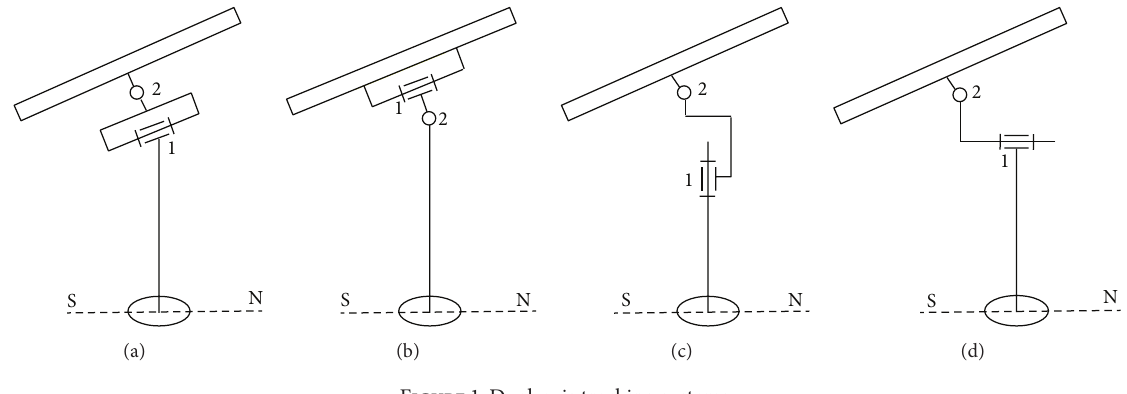
Figure 1: Dual-axis tracking